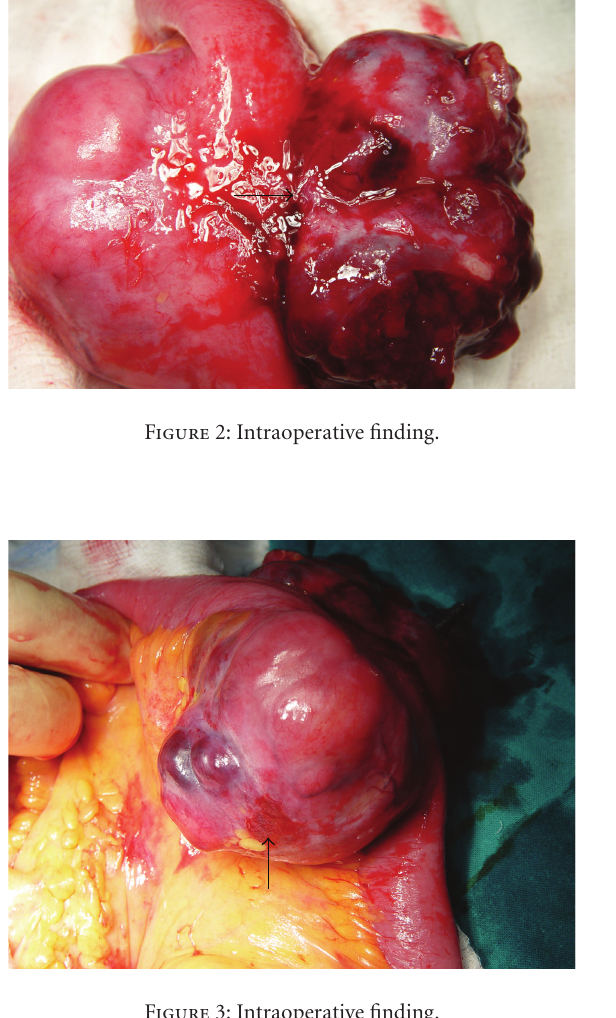
Figure 3: Intraoperative finding.